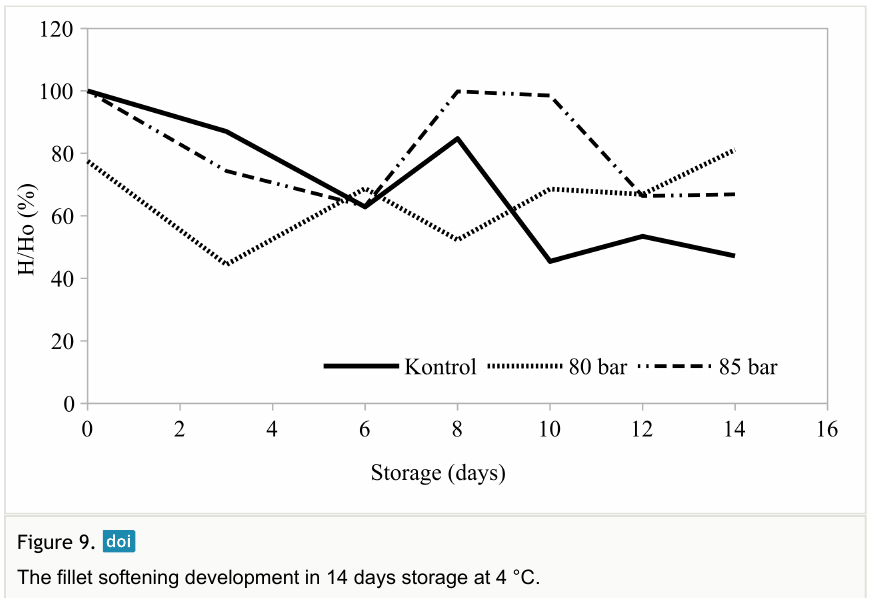
Figure 9. The fillet softening development in 14 days storage at 4 On the final day of observation, untreated samples lost 52.9% of its initial hardness. This finding was in agreement with the softening of climbing perch ( Anabas testudineus ), which lost 50.1% of its initial hardness after 15 days stored in ice (Varghese and Mathew 2017 ). The hardness of 80 bar treated samples was at the same level to its initial hardness, but still lost 18.8% hardness of fresh untreated samples. Eighty-five bar treated samples lost 33.1% hardness of fresh samples, which was better than untreated samples on 14 day of chilled storage.